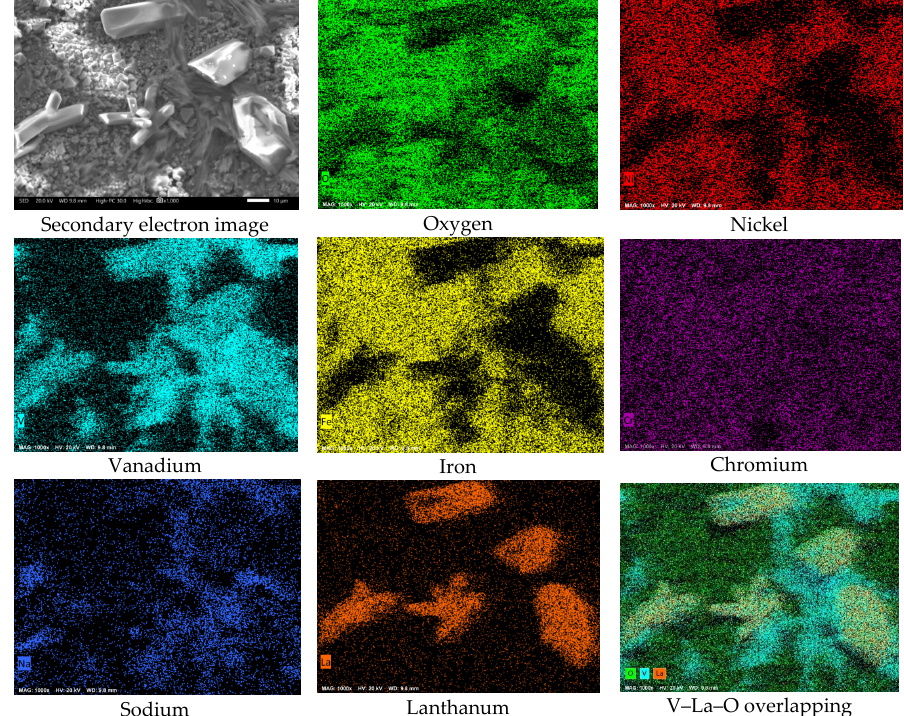
Figure 13. Surface view of the corrosion-product layer and element mapping of the 304H steel corroded in NaVO 3 with 10% La 2 O 3 at 900 °C after 100 h. in NaVO ◦ C after 100 3 with 10% La 2 O 3 at 900